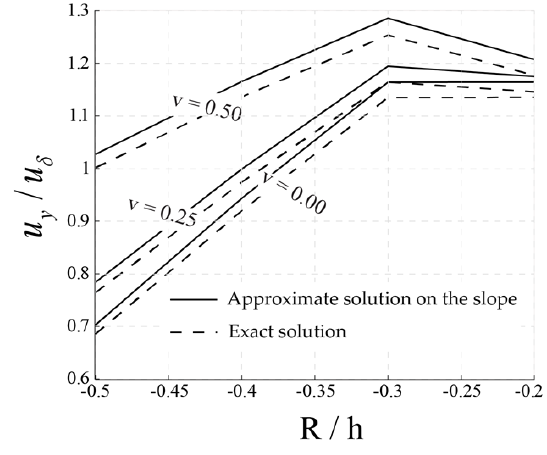
Figure 15. Relationship between the approximate solution on the slope and the exact solution.